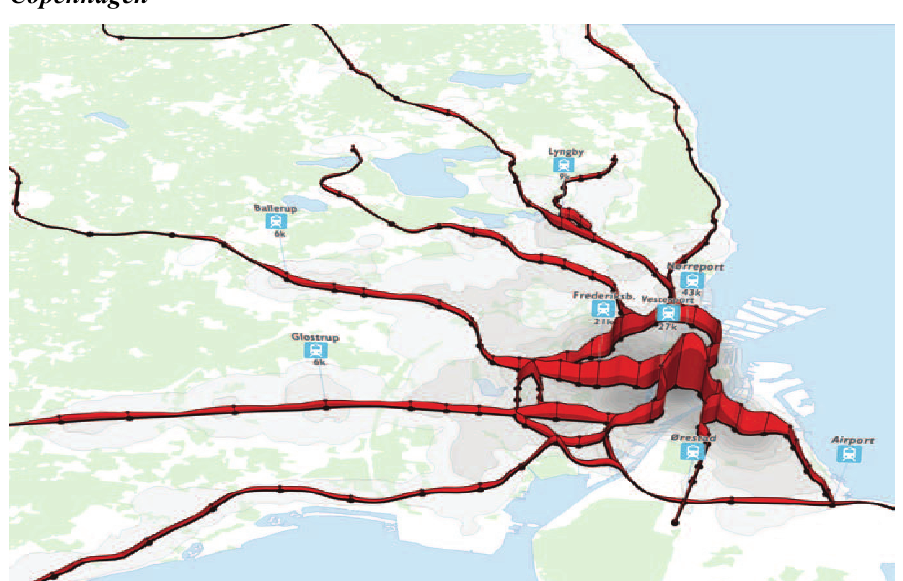
Figure 1: Population and employment density along major transit routes in